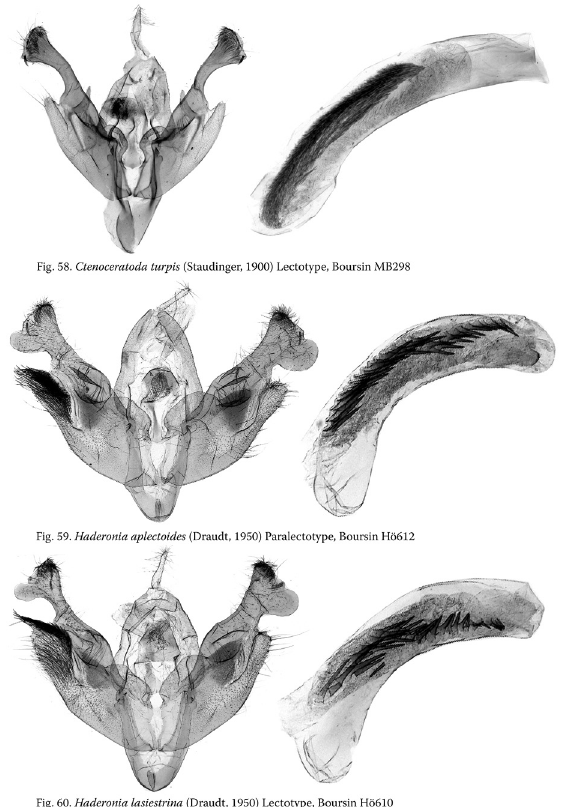
Figure 58–60. 58. Ctenoceratoda turpis (Staudinger, 1900) Lectotype male. 59. Haderonia aplectoides (Draudt, 1950) Paralectotype male. 60. Haderonia lasiestrina (Draudt, 1950) Lectotype